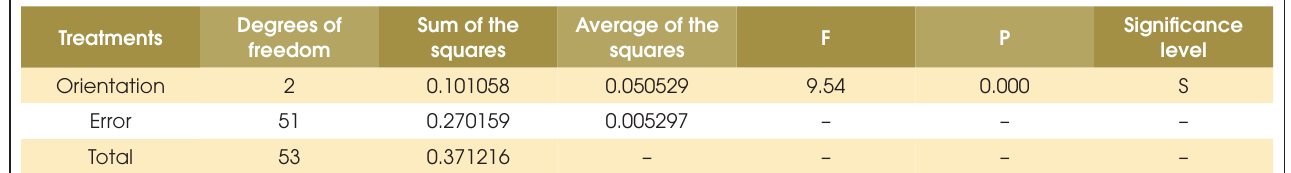
Table 2 – Variance analysis for the form factor – influence of sample preparation